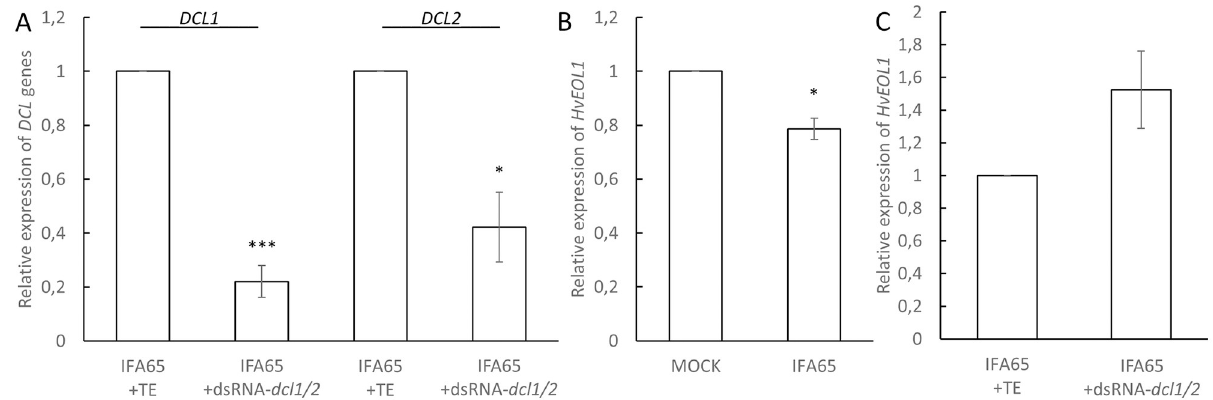
Fig 3. Relative expression of HvEOL1 in response to inoculation of barley leaves with Fusarium graminearum . A, Relative expression of FgDCL1 and FgDCL2 on detached barley cv. Golden Promise leaves at 5 dpi in wt strain IFA65 and 7 days post spray application of the 1,782 nt long dsRNA construct dsRNA- dcl1/2 vs. TE buffer. B , Relative expression of HvEOL1 at 5 dpi with IFA65 vs. mock control. C , Relative expression of HvEOL1 5 dpi with wt strain IFA65 and 7 days post spray application of dsRNA- dcl1/2 vs. TE buffer. Gene expression was first normalized against the reference gene HvUBQ (HORVU1Hr1G023660) and subsequently against the Δ ct of the respective control for B (mock = 0.002% Tween20) and for A,C (IFA65 / TE). Bars represent the mean ± SE of three (B) and four (A, C) independent biological replicates. (Student‘s t -test, � P < 0.05, ��� P < 0,005).